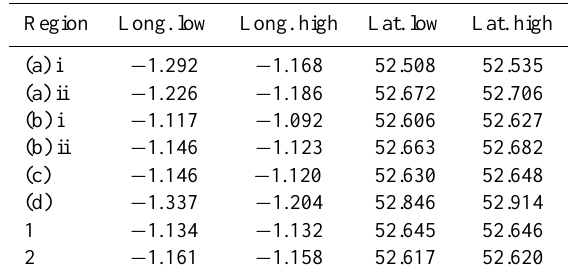
Table 5. Coordinates for regions of interest the top 6 region identi- fiers are associated with Fig. 13, region 1 identifier with Fig. 15 and region 2 identifier with Table 6. (a) Rural areas, (b) suburban areas, (c) city centre area, (d) power station